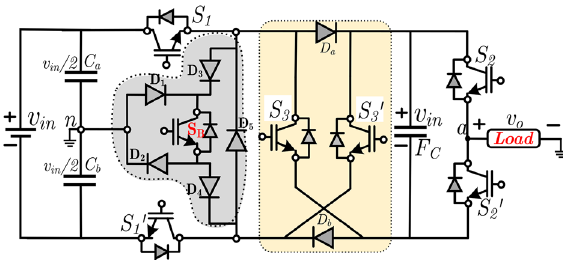
Figure 2. Circuit diagram of proposed 7L ANPC inverter